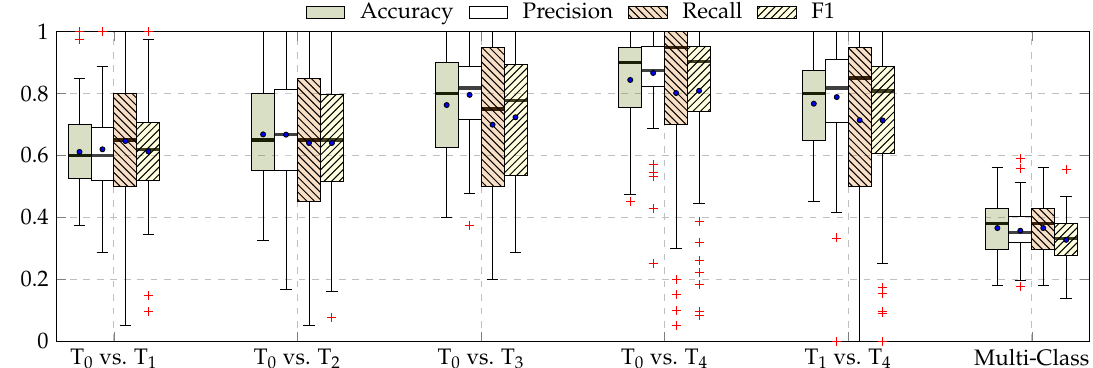
Figure 7. Late fusion classification performance (Late Fusion (b)). Within each box plot, the mean and median values of the respective performance evaluation metrics are depicted with a dot and a horizontal line, respectively.